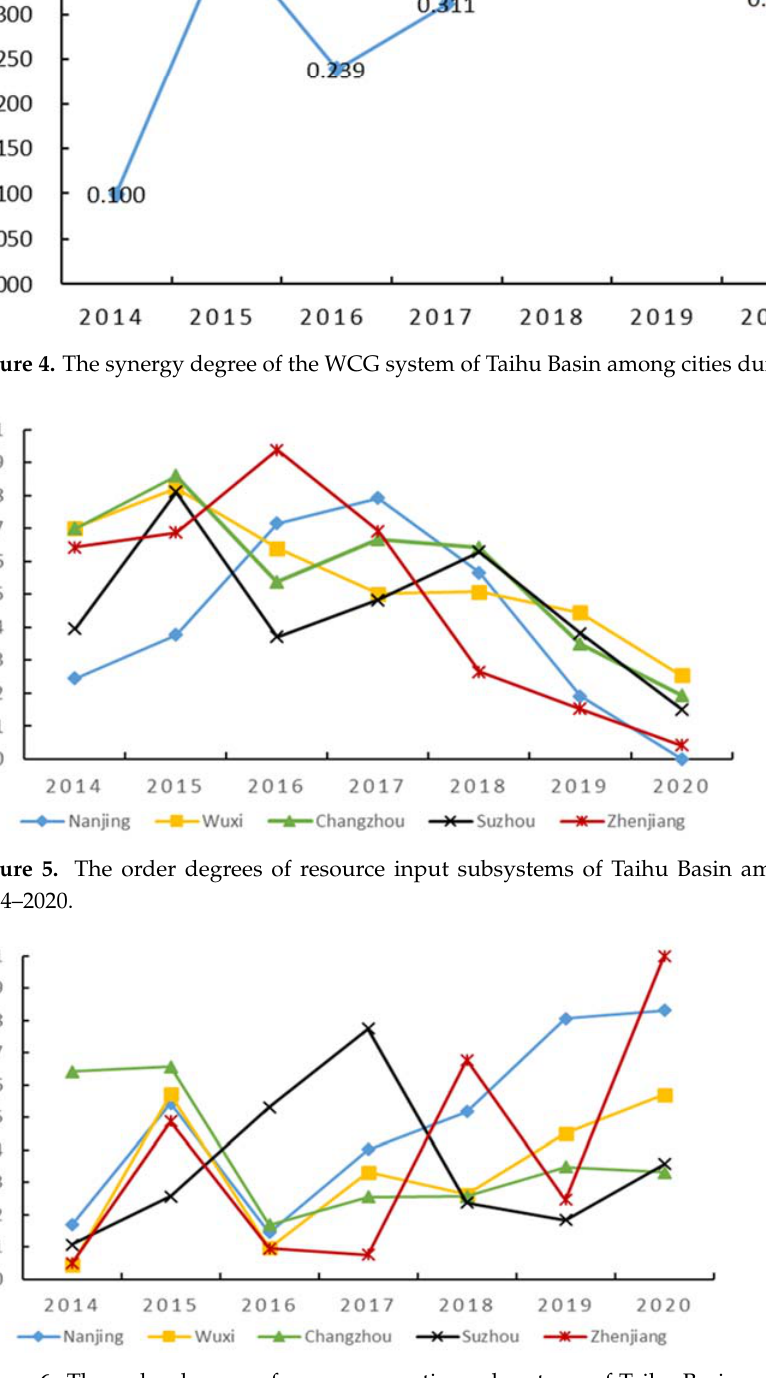
Figure 7. The order degrees of performance supervision subsystems of Taihu Basin among cities during 2014–2020.